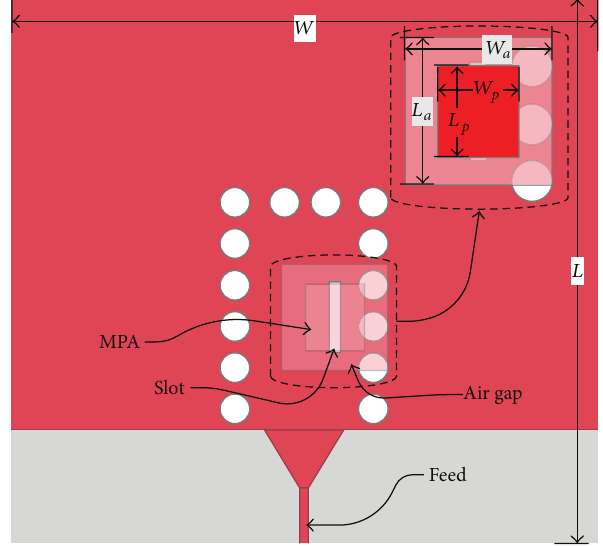
Figure 3: Top view of proposed membrane antenna geometry.